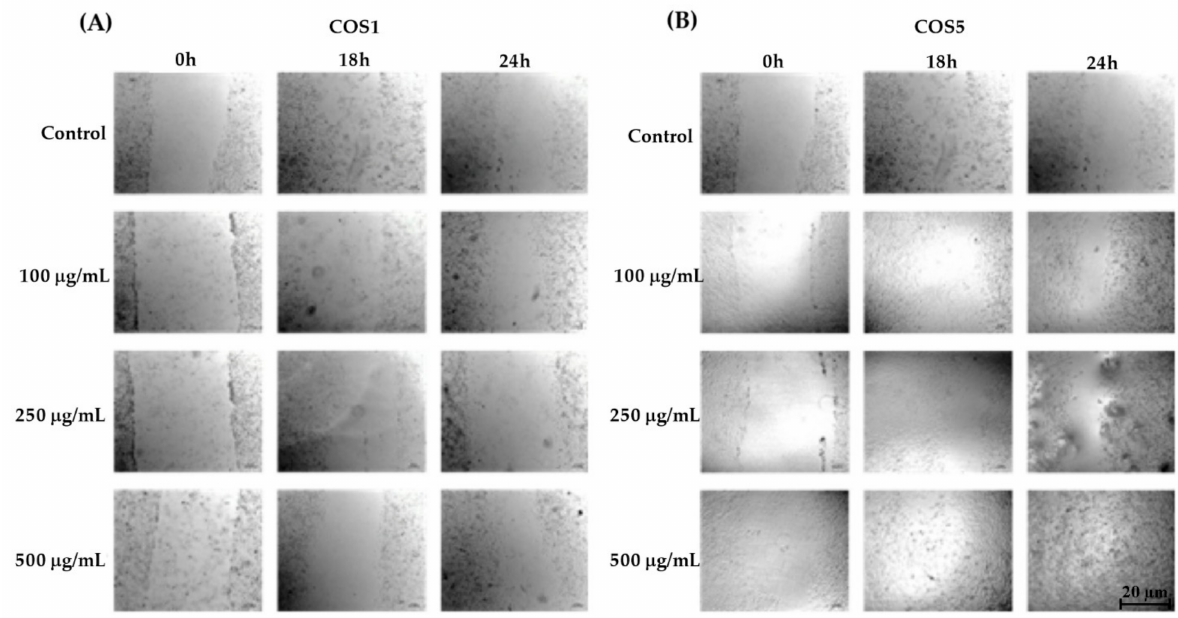
Figure 6. Actions of COS1 ( A ) and COS5 ( B ) at different concentrations in the “scratch” cell migration model demonstrated in the well photos for different groups at 0, 18, and 24 h of the